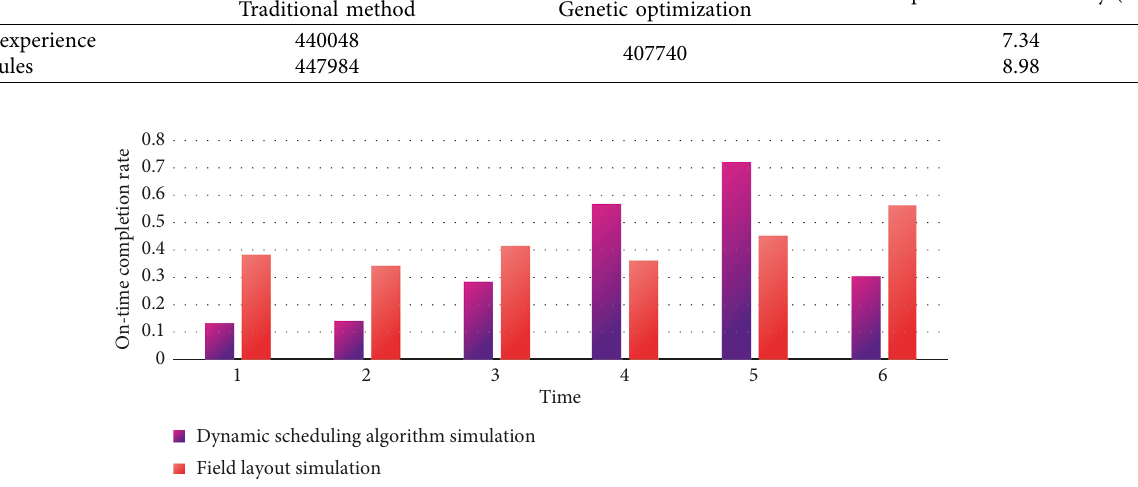
Figure 5: Mold completion rate statistics after improvement.